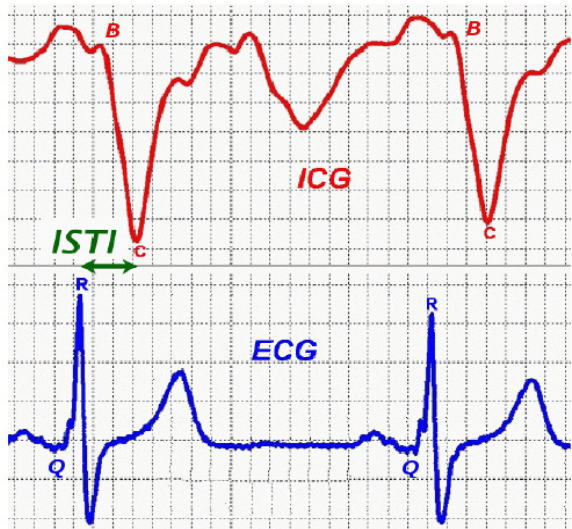
Fig.1: ISTI is defined as the dime delay between the R-peak of the ECG signal and the C-point in the ICG